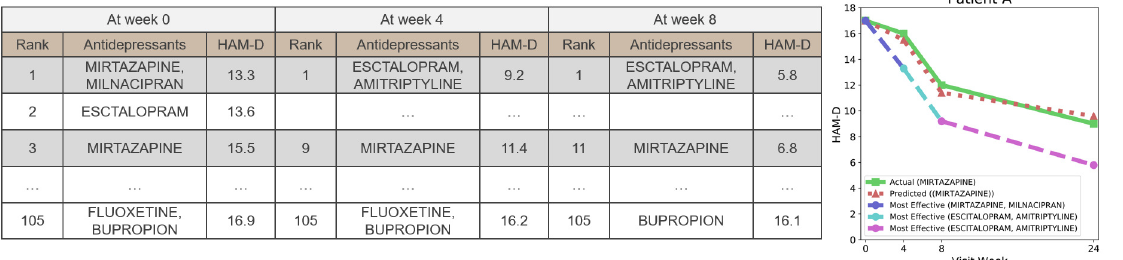
Figure 3. The use case where the most effective antidepressant is prescribed. The first tables show the ranked predicted HAM-D scores of Patient A at their first visit. A green line indicates an actual change in the HAM-D score of Patient A. A red line indicates a change in the HAM-D score predicted by ARPNet for the prescribed antidepressant MIRTAZAPINE. The blue line indicates the changes in the predicted HAM-D score when Patient A is prescribed MIRTAZAPINE and MILNACIPRAN, which are predicted to be the most effective at first visit. The cyan and pink lines indicate the predicted HAM-D score changes of Patient A when the antidepressants are changed to ESCITALOPRAM and AMITRIPTYLINE. ESCITALOPRAM and AMITRIPTYLINE are the most effective antidepressants predicted by ARPNet in Weeks 4 and